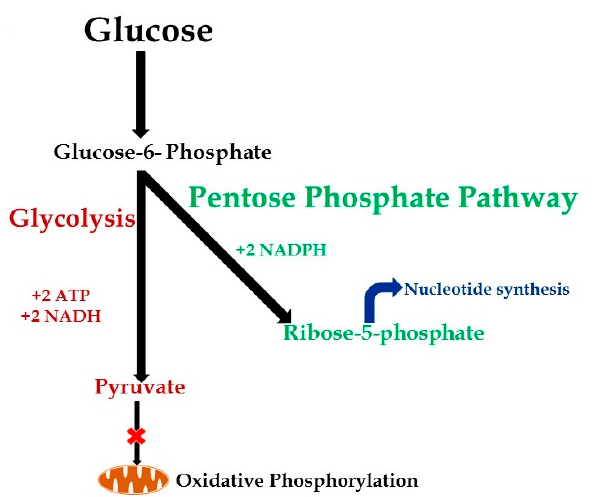
Figure 2. Aerobic glycolysis in activated immune cells: Activated immune cells undergo aerobic glycolysis; there is inhibition of oxidative phosphorylation in these cells. In addition, there is a selective increase in the pentose phosphate pathway in these cells resulting in ribose-5-phosphate to facilitate nucleotide synthesis to support cell proliferation.